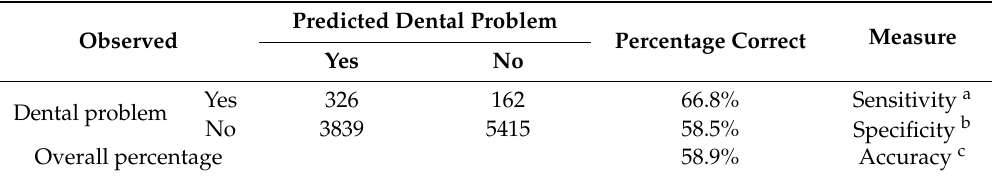
Table 2. Confusion matrix showing selected performance measures for Classification tree analysis of dental problem prevalence in the Growing Up in Ireland infant cohort at 3-years of